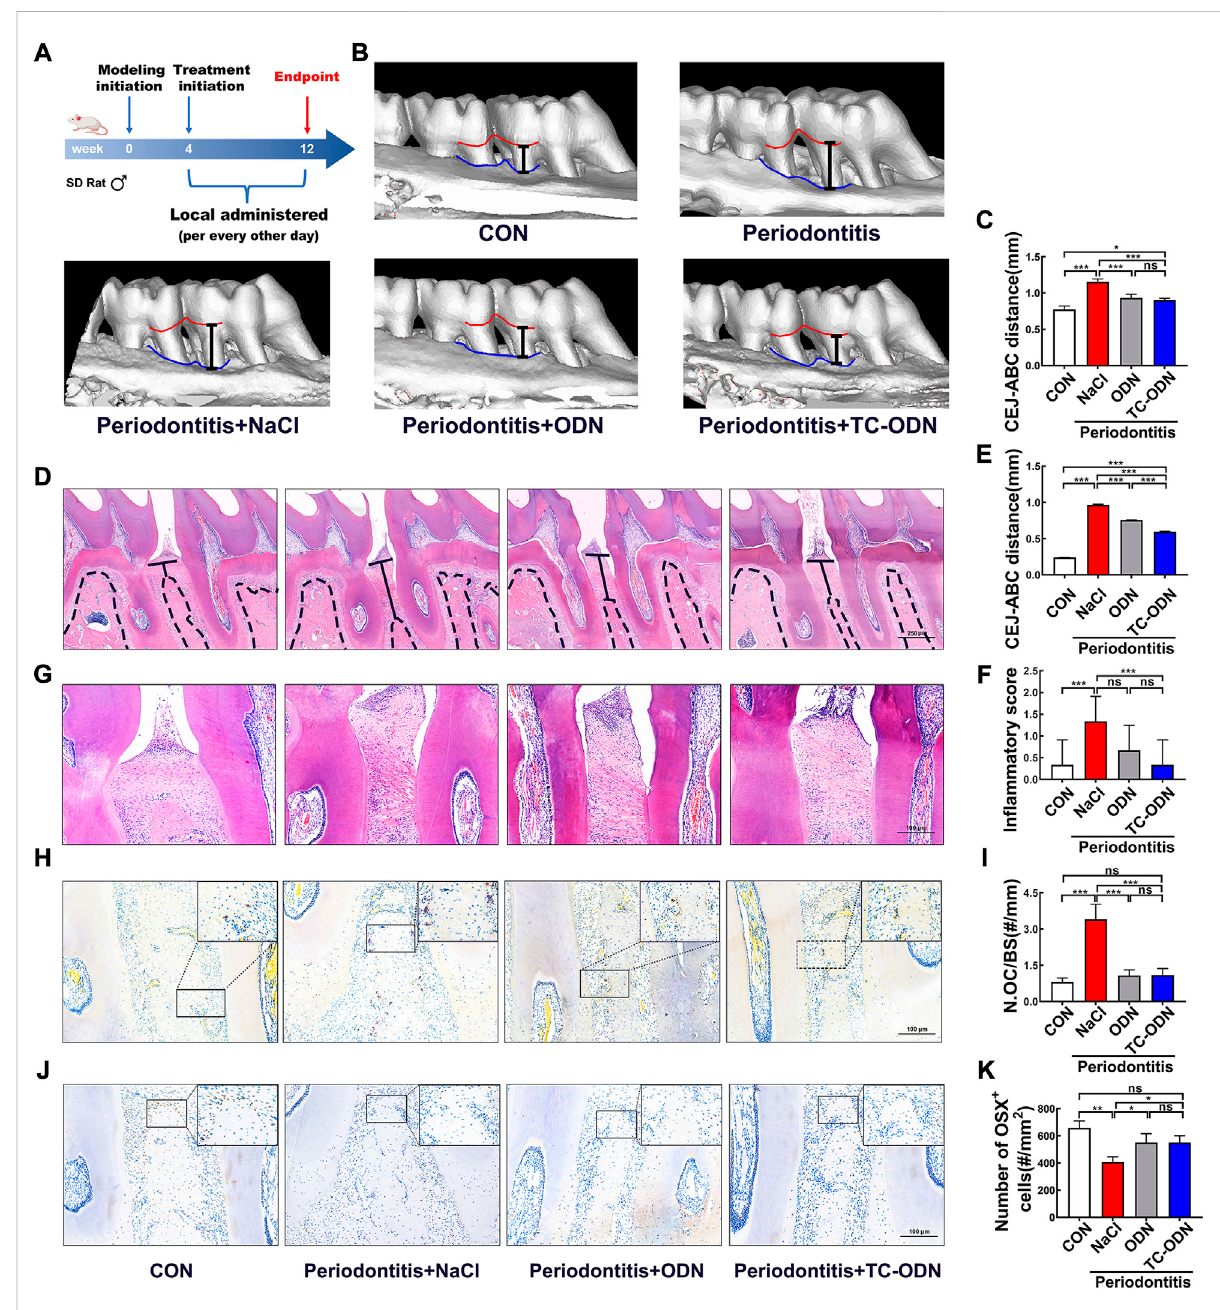
FIGURE 6 Therapeutic ef fi cacy of TC-ODN in rat experimental periodontitis. (A) The therapeutic design of the experimental periodontitis. (B) Micro-CT scanning at the endpoint in each group. (C) The linear distance from cementoenamel junction to alveolar bone crest (CEJ-ABC) determined according to Micro-CT ( n = 3). (D) Representative images of hematoxylin and eosin (H,E) staining of the teeth and periodontal tissues in each group. (E) TheCEJ-ABC distanceaccordingtoH&Estaining(n=3). (F) RepresentativeimagesofH&Estainingofthegingivaltissuebetweenthe fi rstmolarandthesecond molarineach group. (G) Scoreofin fl ammatorycellsaccordingto H&Estaining( n =3). (H) Representative images ofTRAP staining between the roots of the fi rst molar and the second molar. (I) TRAP-positive osteoclasts were counted ( n = 3). (J) Representative images of IHCstainingofOsterixbetweentherootsofthe fi rstmolarandthesecondmolar. (K) NumberofOsterix + cells( n =3).Dataarepresentedasmeans± SD. * p < 0.05, ** p < 0.01 and *** p < 0.001 by one-way